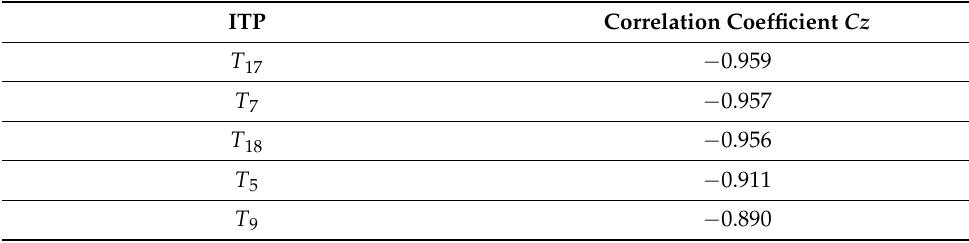
Table 3. The strongest negative correlations of five ITPs with spindle